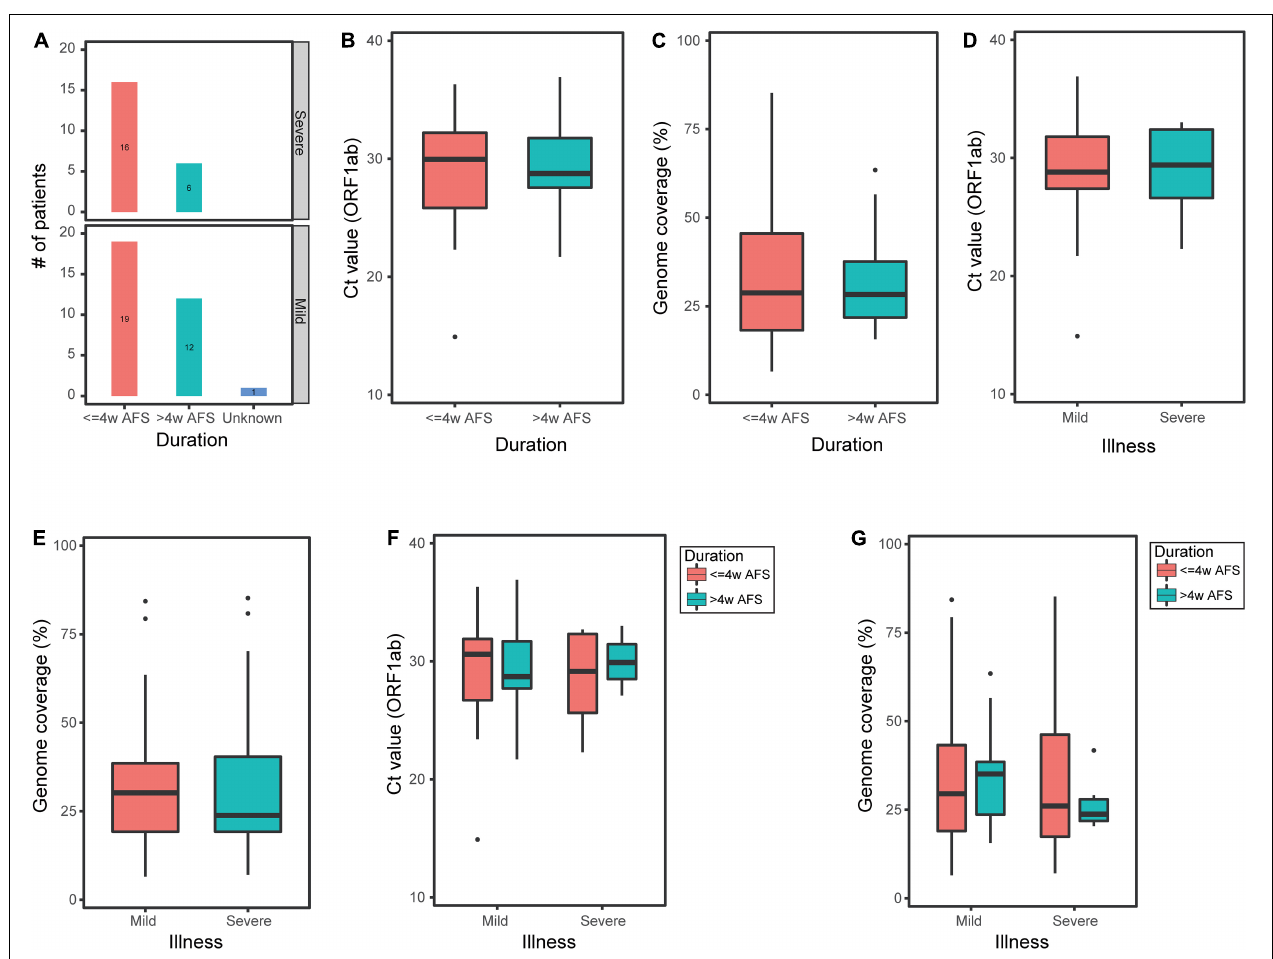
FIGURE 3 | C t value of ORF1ab and reference genome coverage in pharyngeal swabs from COVID-19 patients. (A) Number of pharyngeal swabs from mild or moderate patients (mild group) and critical or severe patients (severe group) within less or longer than 4 weeks after onset of clinical manifestations ( ≤ 4w AFS or > 4w AFS , respectively). (B,C) C t value and reference genome coverage in pharyngeal swabs from patients with ≤ 4w AFS or > 4w AFS. (D,E) C t value and reference genome coverage in pharyngeal swabs from mild or severe groups. (F,G) C t value and reference genome coverage in pharyngeal swabs in four groups based on both the time of diagnosis and the severity of patients. COVID-19, coronavirus disease 2019; AFS, after first showing clinical manifestations; C t , cycle